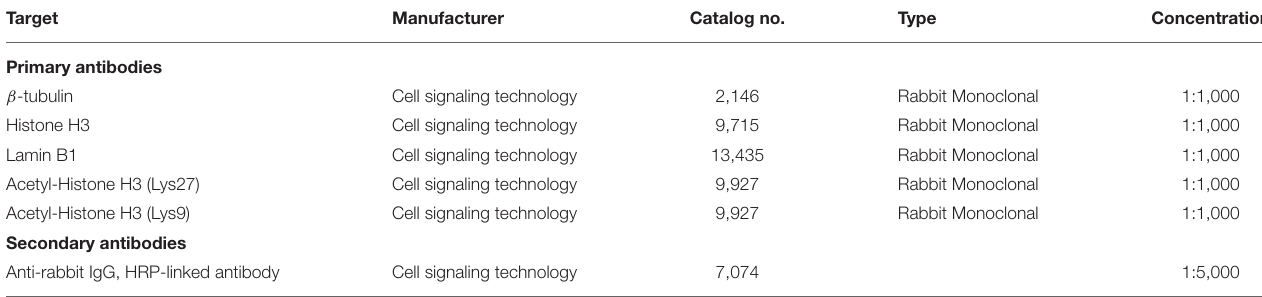
TABLE 1 | Antibodies used for western